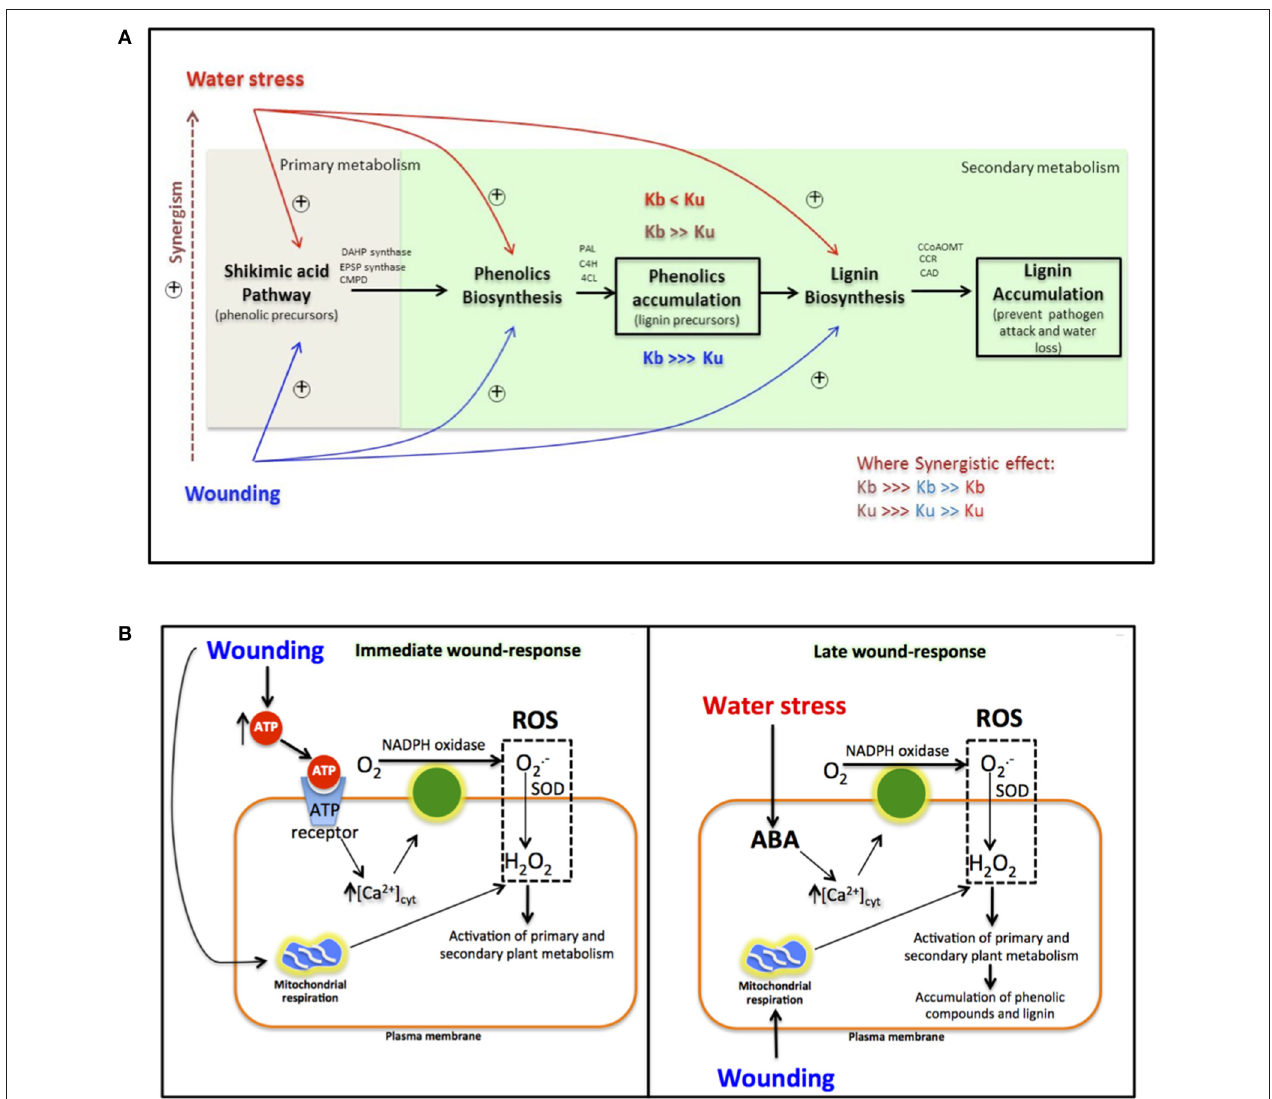
FIGURE 3 | Effect of water and wounding stress on the gene modulation of primary and secondary metabolic pathways associated with the biosynthesis of phenolic compounds in carrots (A). Phenolic biosynthesis rate (Kb) and phenolic utilization rate (Ku), associated to lignin biosynthesis for the prevention of pathogen attack and water loss, define the accumulation or decrease of phenolic compounds. Activation of metabolic pathways by water stress and wounding stress, are indicated by red and blue, respectively, while synergistic effects are indicated by brown color. Hypothetical model integrating wounding and water stress signaling pathways in carrots (B) . The integration of both signaling pathways (wounding and water stress) at the late wound-response, could result on an exacerbated ROS production, which could be responsible of the synergistic effect observed (A) on the wound-response of carrots treated with additional